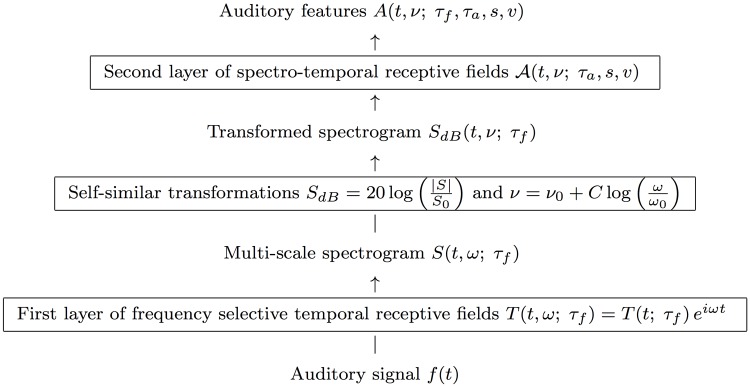

Schematic illustration of the definition of auditory features from a second layer of receptive fields over the spectrogram, where we also allow for a logarithmic transformation of the magnitude values ∣S∣ of the spectrogram prior to the application of the second layer of linear receptive fields and make use of a logarithmic transformation of the frequencies ν=ν0+Clog(ωω0) before defining the linear receptive fields over the spectro-temporal domain.Regarding the scale parameters, the first layer of temporal receptive fields depends on a single temporal scale parameter τ
f for the frequency selective temporal filters, whereas the second layer of auditory receptive fields also depends on an additional temporal scale parameter τ
a, a logspectral scale parameter s over the logarithmic frequencies ν and a glissando parameter v representing the rate by which the logarithmic frequencies may vary over time.